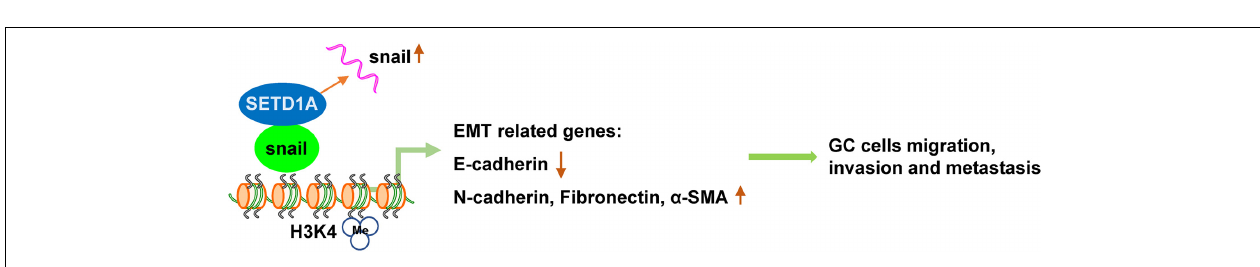
FIGURE 7 | Working model: STED1A promotes GC cell migration, invasion, and metastasis through enhancing snail-associated EMT.